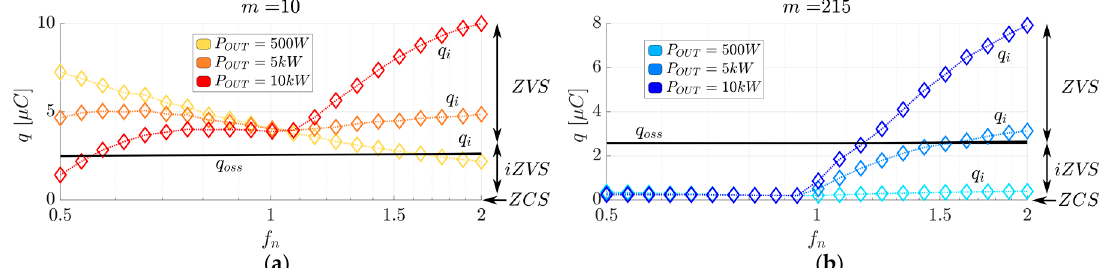
Figure 15. Time-based model simulations: inductive charge ( q i ) and transistor output capacitor charge ( q oss _ Total ), where iZVS stands for incomplete ZVS. ( a ) for m = 10; ( b ) for m = 215.